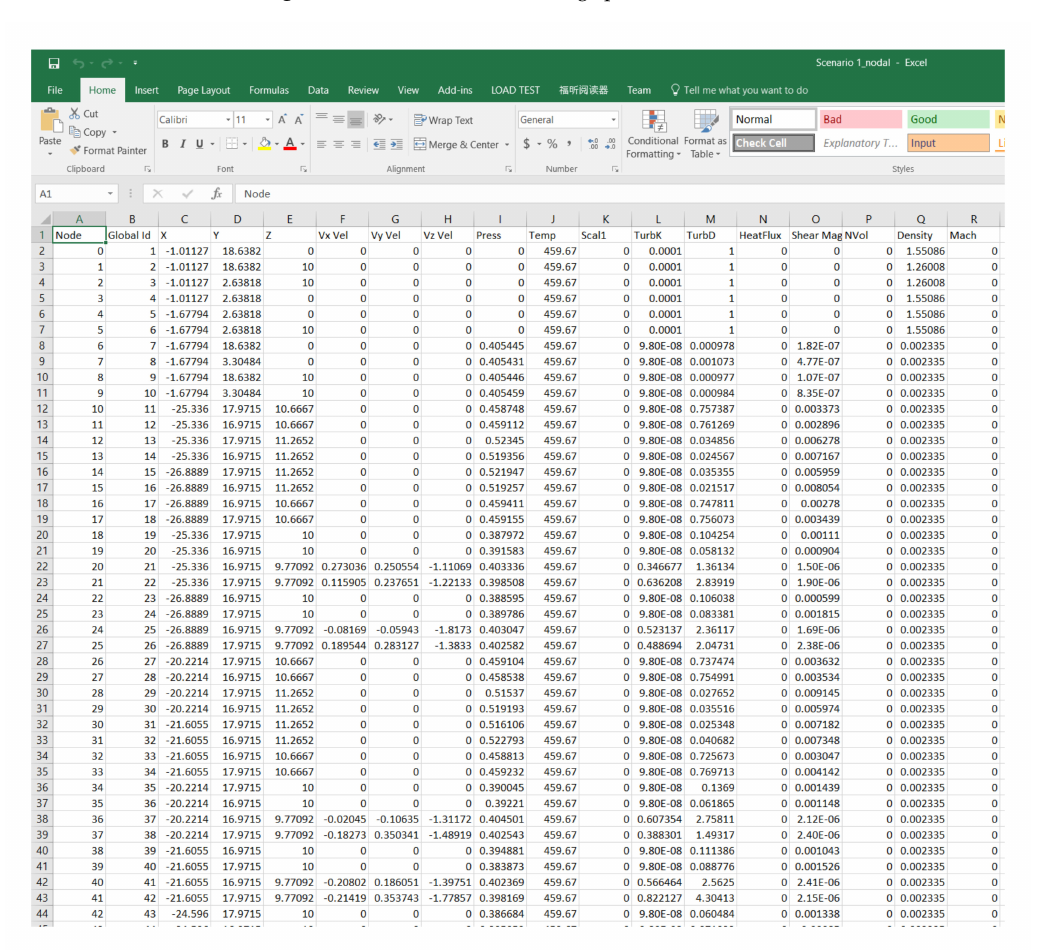
Figure 10. The wind flow tracing splines are added.